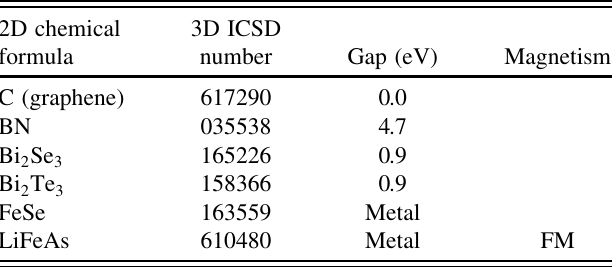
by our search algorithm. The ICSD number of the corresponding bulk material, the calculated band gap of the two-dimensional material, and its magnetic state (FM refers to a ferromagnetic ordering) are given as well. (The cells of the table are left blank if the material is not magnetically